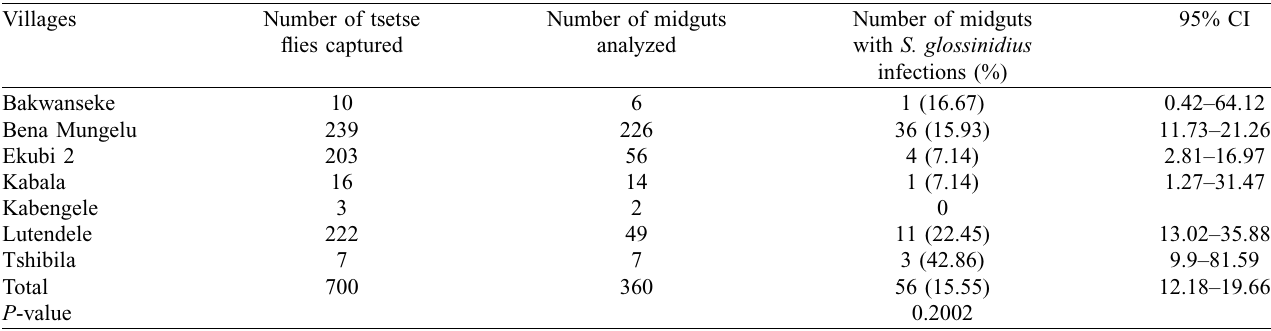
Table 2. Infection rates of S. glossinidius according to villages. Villages